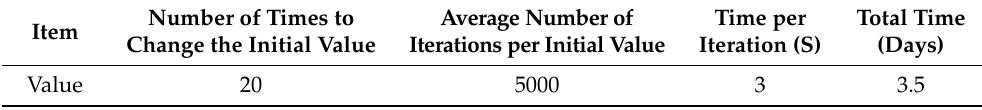
Figure 28. The diffraction efficiency after 150 iterations. ( a ) The 5th order; ( b ) the 4th order. Table 6. The time spent designing AH53_opt’ with VirtualLab Fusion software.